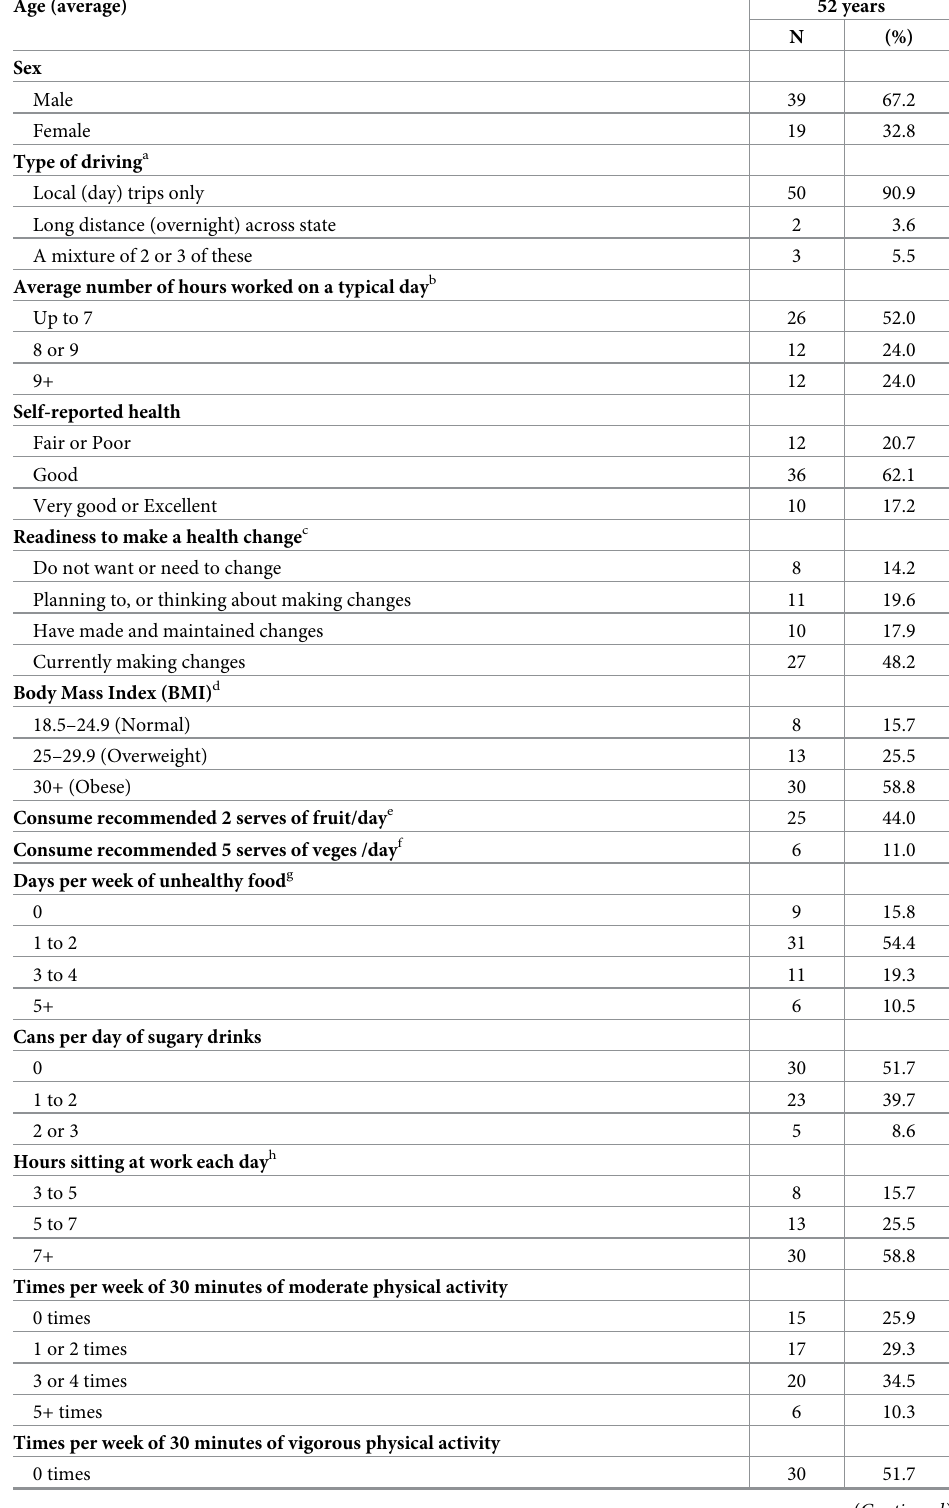
Table 1. Selected characteristics of bus driver questionnaire respondents (n =